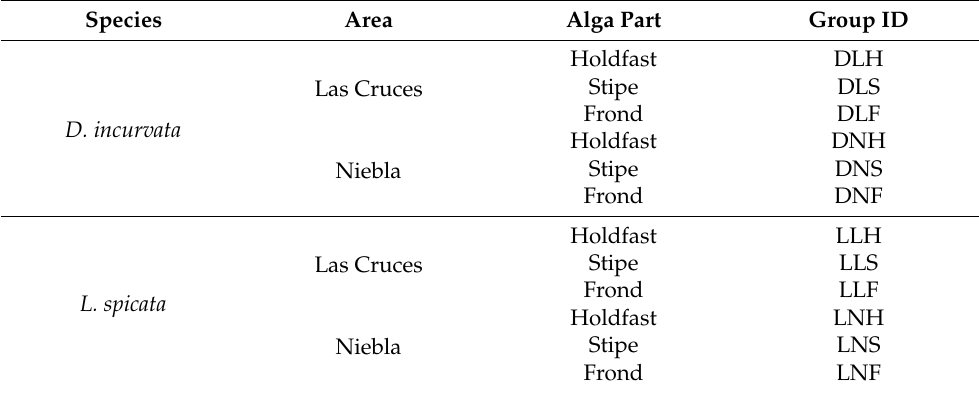
Table 1. Identification and description of the twelve sample groups assessed in this study. Each group includes five